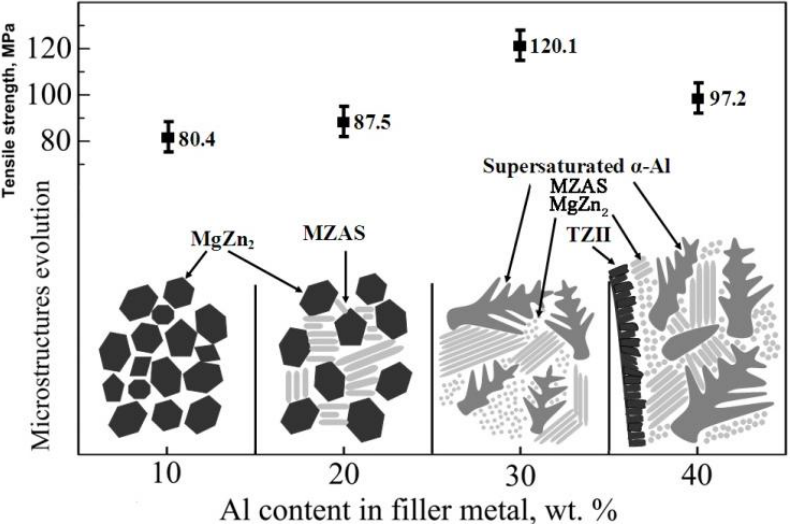
Figure 8. Tensile strength and microstructure evolution of joints with different Al contents in filler